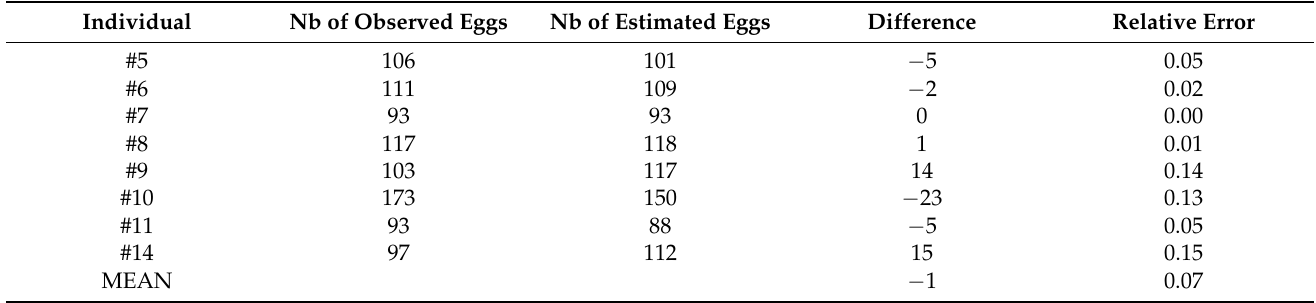
Table 3. Estimations of the number of laid eggs for eight green turtles from the Egg laying period identified by the V-net and/or manually extracted from the acceleration visualization compared to the actual observed numbers on the